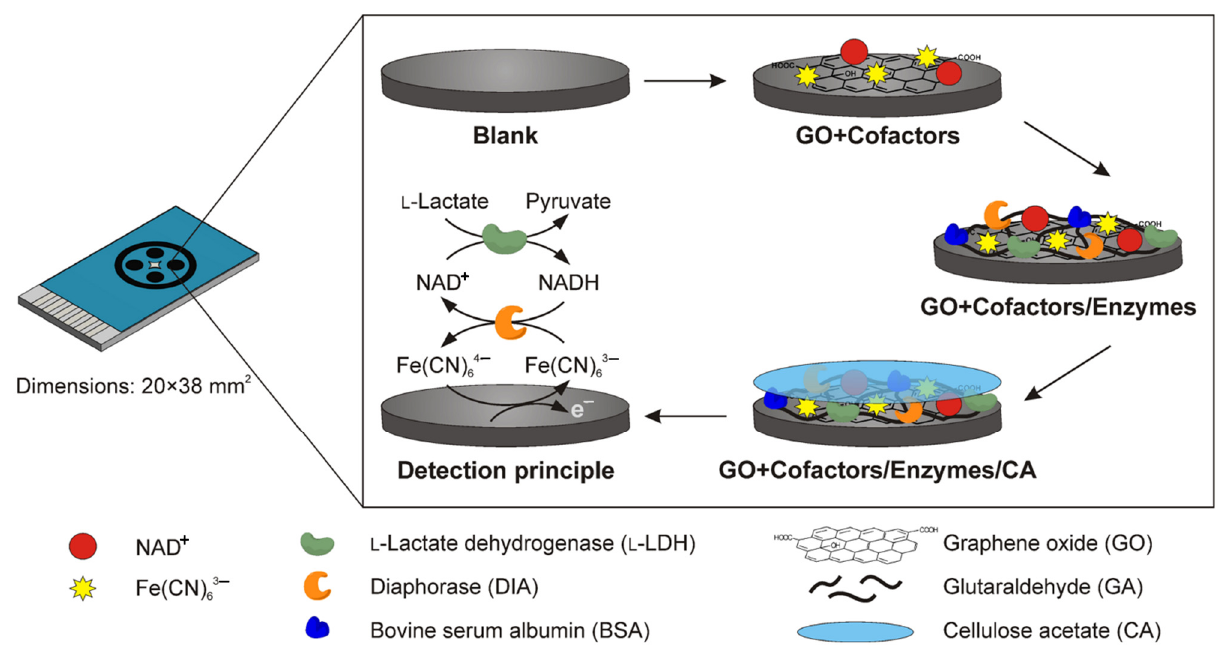
Figure 13. Schematic representation of the multianalyte SPE biosensor (adapted and reprinted with permission from [154]).